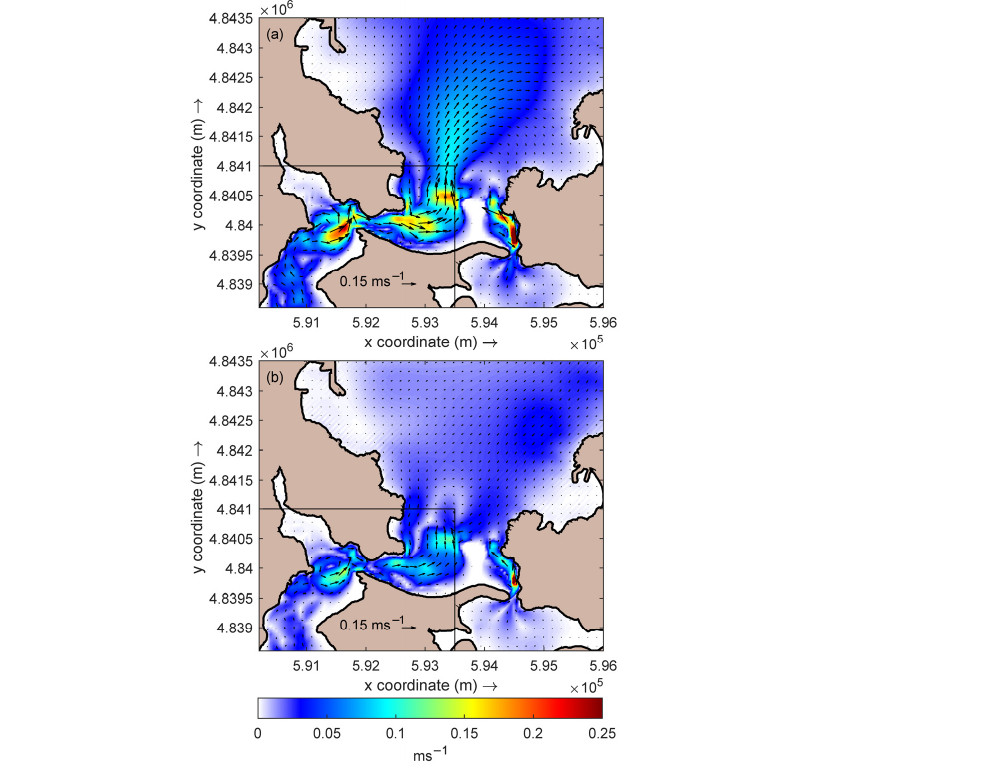
Figure 4. Residual flow pattern in Ria de Ortigueira under case study CS1 conditions. ( a ) Surface layer; ( b ) bottom layer.